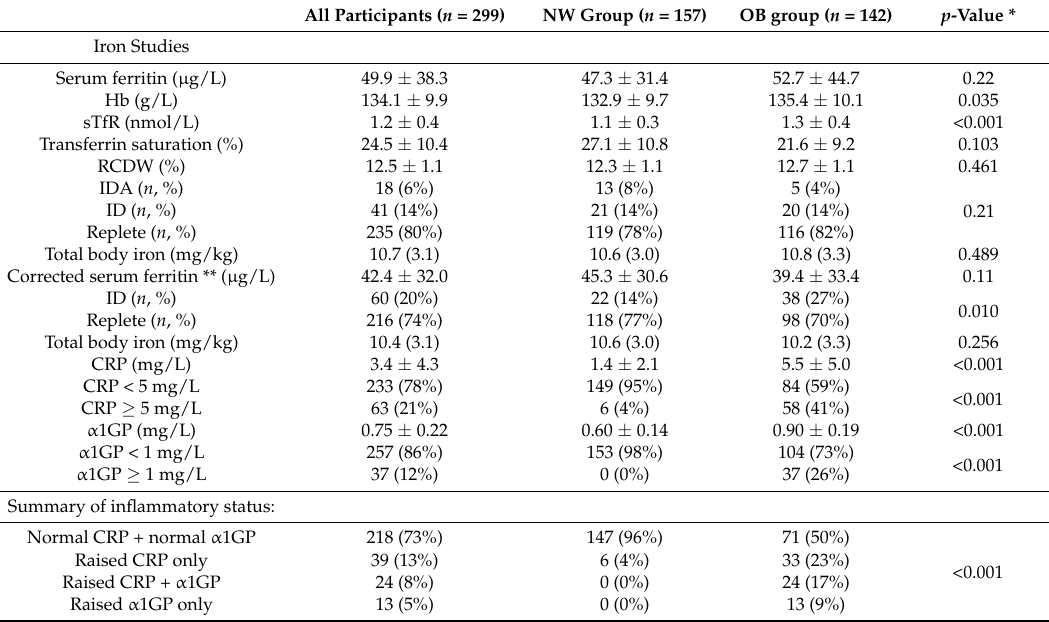
Table 2. Participant iron and inflammatory